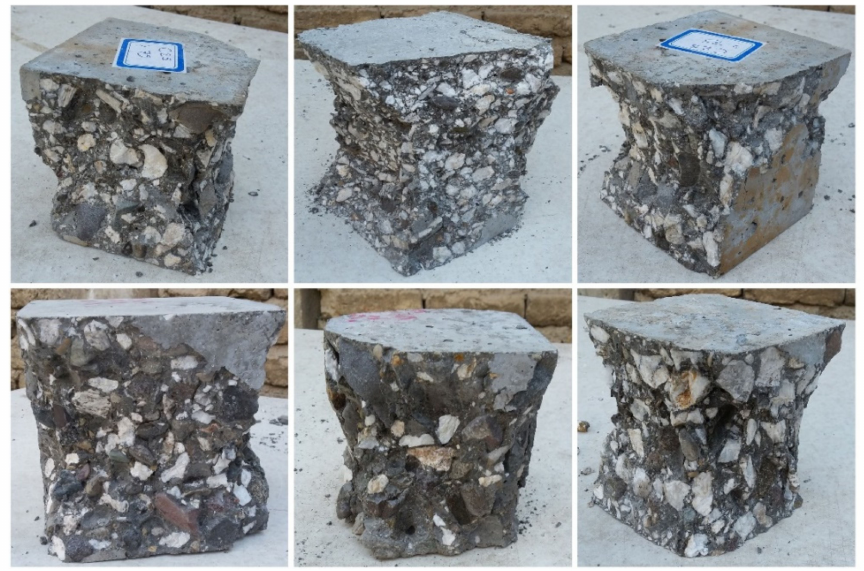
Figure 10. The dominant failure mode for cubic